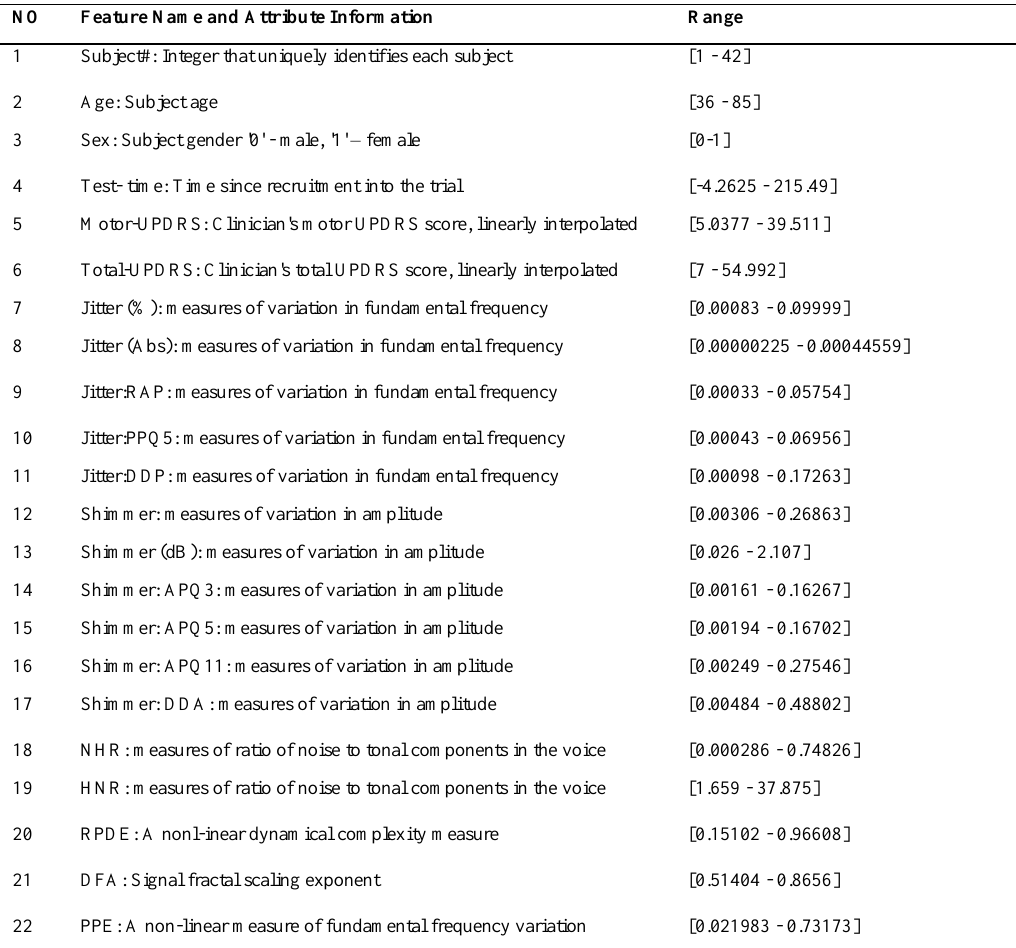
Table 1. Dataset from UCI related to PD.